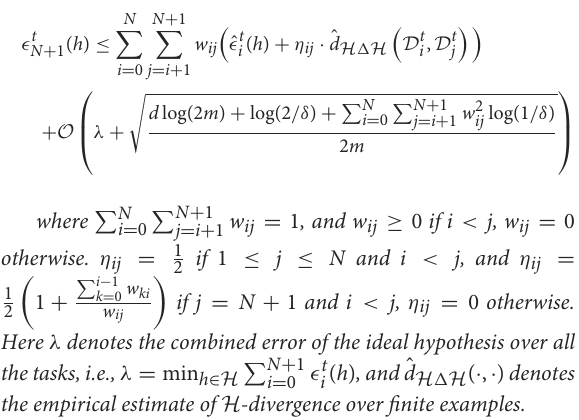
L ( y , y ) y y . The following theorem showed that the ˆ = |ˆ − | expected error of the newest target task D t in terms of the historical source and target